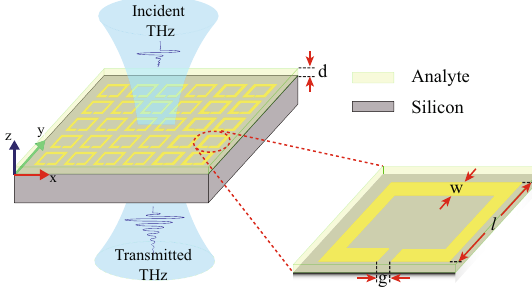
Figure 1. Schematic of planar Terahertz metamaterial geometry consisting of SRRs on silicon substrate. A single unit cell consists of SRR of gold metal (magnified for a closer view). The yellow region represents SRR. SRR has outer dimensions of l × l = 36 μ m × 36 μ m . The w and g in the schematic stand for the width and the split gap of SRR, respectively. Parameter d represents thickness of the analyte, which can be varied. Green coloured y -axis represents polarization direction of the electric field of incident Terahertz